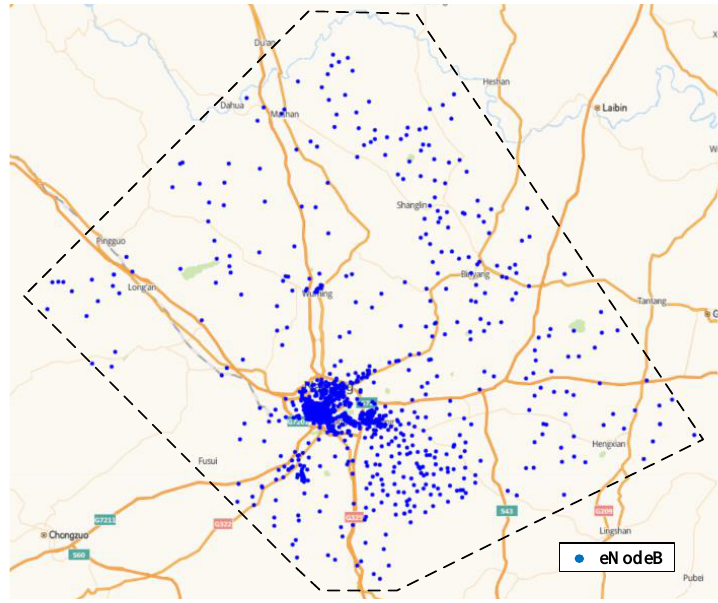
Figure 9. Geographic image of the data source